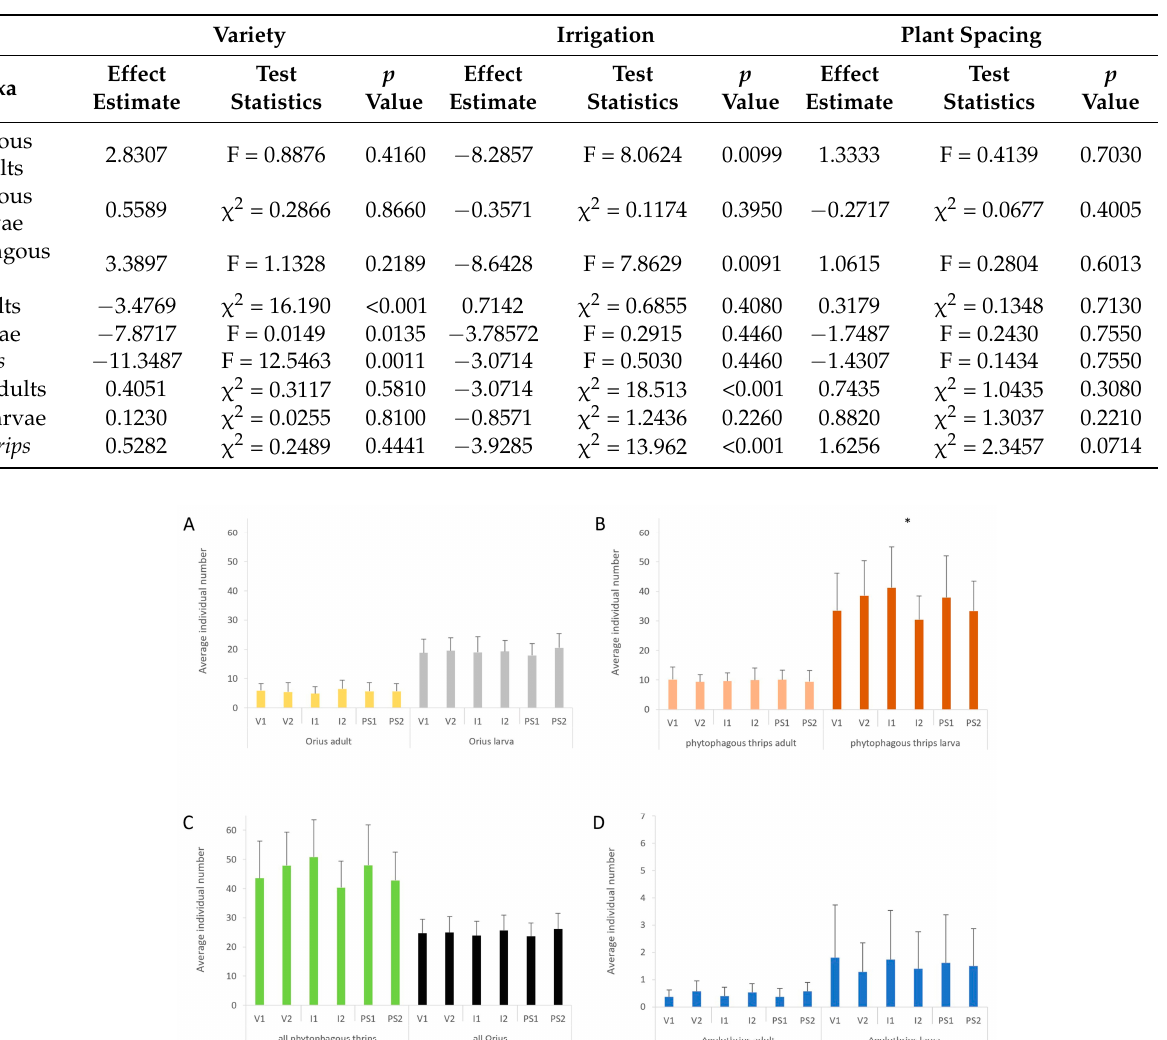
Table 2. Effects of variety, irrigation level and plant spacing on the insect abundance of chili flowers in 2019. Residual degrees of freedom were 138 in all tests.